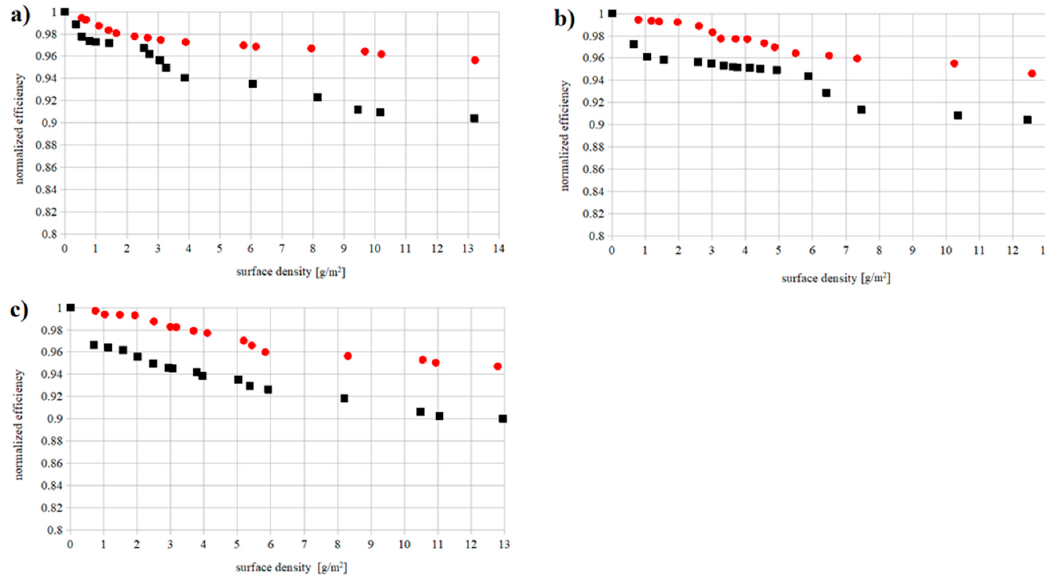
Figure 7. Normalized efficiency η / η MAX for: ( a ) dust 3, ( b ) dust 5, ( c ) dust 6, covering the surface of two PV modules—( ● ) MWG-20 and ( ■ ) CLC010-12P.